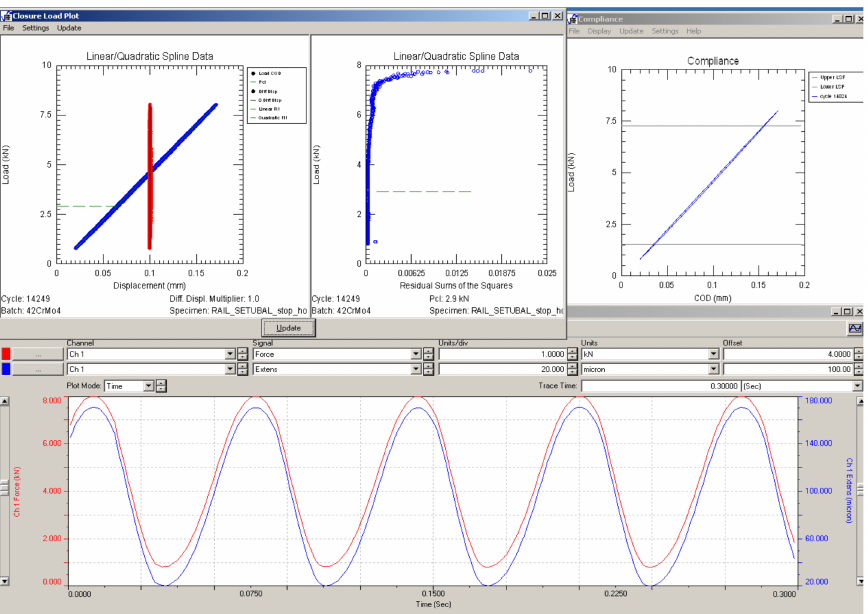
Figure 5. Sinusoidal waveform of loading and measured hysteresis loops and elastic compliance for crack length